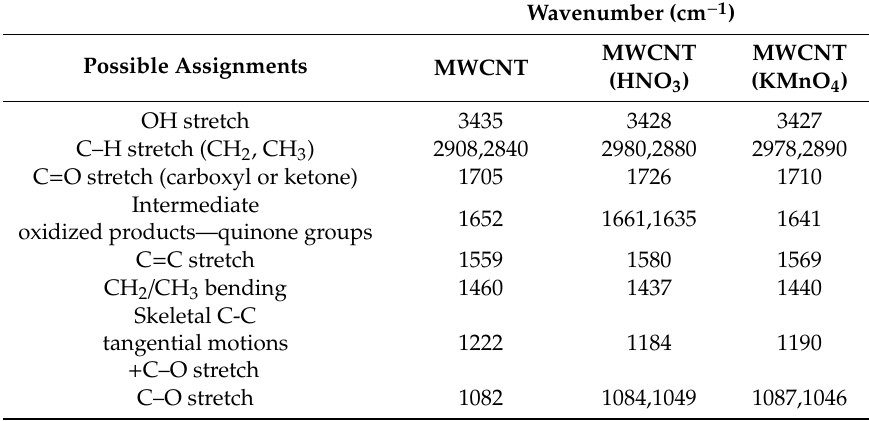
Table 1. Summary of FTIR measurements for the pristine and oxidized MWCNT networks.